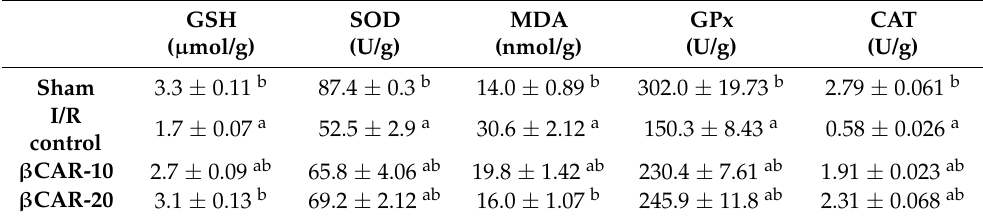
Table 1. Effect of β CAR on oxidative stress biomarkers in cerebral I/R rats.